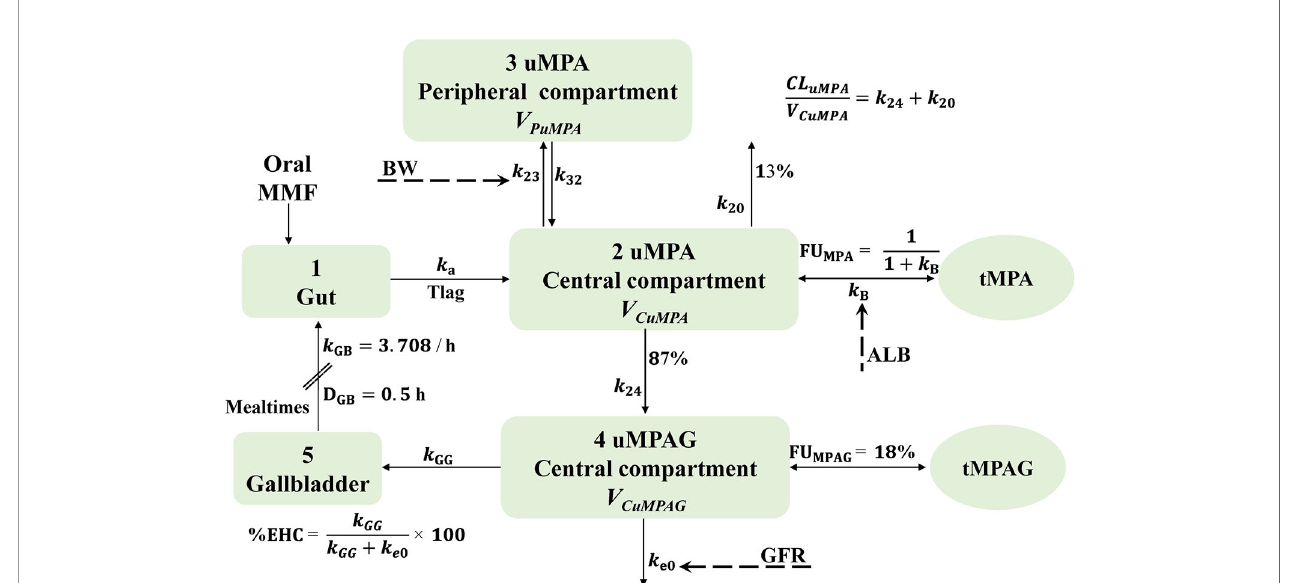
FIGURE 1 | Schematic representation of the fi nal structural model characterizing the linear protein binding and intermittent EHC processes. In this model, mealtimes are used as an index of gallbladder emptying. This process is assumed to occur at speci fi c time points (mealtimes) with a fi rst-order rate constant and a certain duration. The fraction of MPA metabolized to MPAG is fi xed at 87%. MMF, mycophenolate mofetil; MPA, mycophenolic acid; MPAG, 7-O-mycophenolic acid glucuronide; tMPA, total MPA; tMPAG, total MPAG; uMPA, unbound MPA; uMPAG, unbound MPAG; ALB, serum albumin; BW, body weight; CL uMPA /F, apparent clearance of uMPA; D GB , duration of gallbladder emptying; EHC, enterohepatic circulation; %EHC, percentage of MPAG recycled into the systemic circulation; FU MPA , unbound fraction of MPA; FU MPAG , unbound fraction of MPAG; GFR, glomerular fi ltration rate; k 20 , elimination rate constant of uMPA; k 23 , transfer rate constant from uMPA central compartment to peripheral compartment; k 24 , rate constant of uMPA transformed to uMPAG; k 32 , transfer rate constant from uMPA peripheral compartment to central compartment; k a , absorption rate constant; k B , protein binding rate constant; k e0 , elimination rate constant of uMPAG; k GB , gallbladder emptying rate constant; k GG , transfer rate constant from uMPAG central compartment to gallbladder; Tlag, lagged absorption time; V CuMPA /F and V CuMPAG /F, apparent central volume of distribution of uMPA and uMPAG, respectively; V PuMPA /F, apparent peripheral volume of distribution of